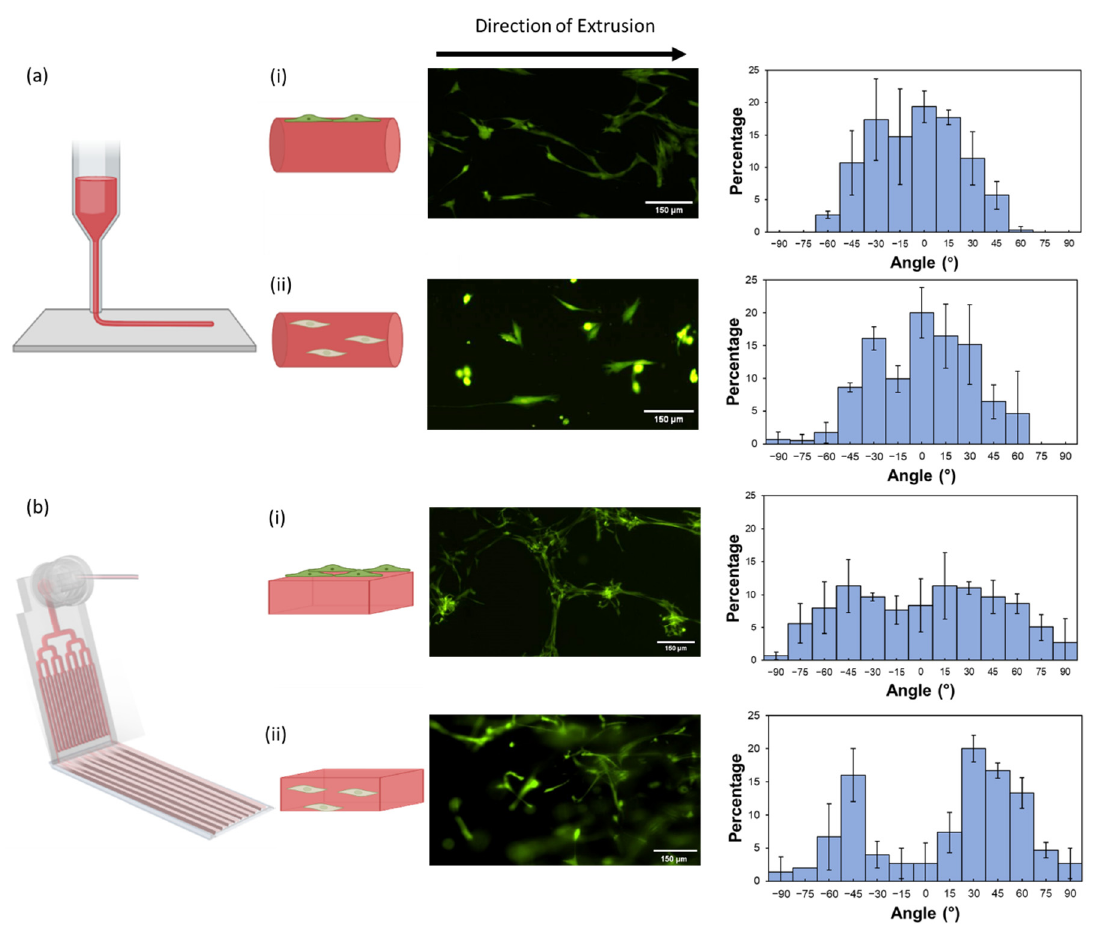
Figure 5. Characterization of HDF orientation during their 2D and 3D culture using extruded struc- turally anisotropic hydrogels. ( a ) Hydrogel sheets extruded from a nozzle printhead. (i) 2D culture of HDFs on the hydrogel threads on Day 1. (ii) 3D culture of HDFs encapsulated in the hydrogel threads on Day 6. ( b ) Hydrogel threads extruded from a microfluidic printhead. (i) 2D culture of HDFs on the hydrogel sheets on Day 6. (ii) 3D culture of HDFs encapsulated in the hydrogel sheets on Day 6. Middle column: fluorescence images of calcium-AM-stained HDFs cultured on or within the hydrogel. Right column: histograms of HDF cell orientation upon their culture on or within hydrogels on/in the hydrogels. Hydrogel composition: C a-CNF = 1.0 wt.%, C gelatin = 4.0 wt.%. Each error bar represents the standard deviation acquired in three independent samples.